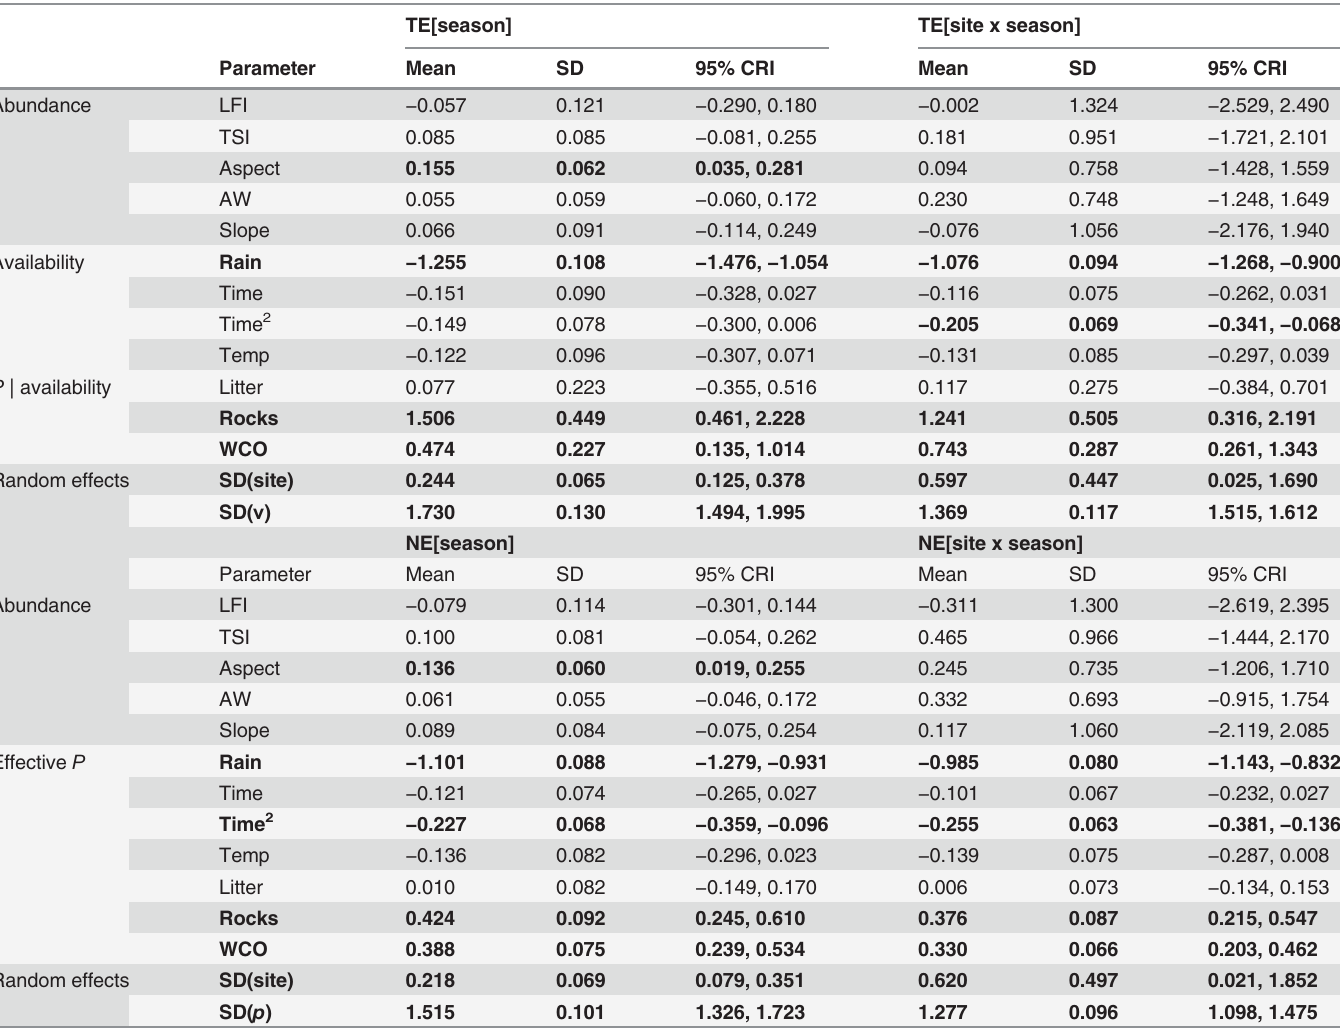
Table 2. Comparison of posterior means and 95% Bayesian credible intervals of model parameters for four binomial mixture